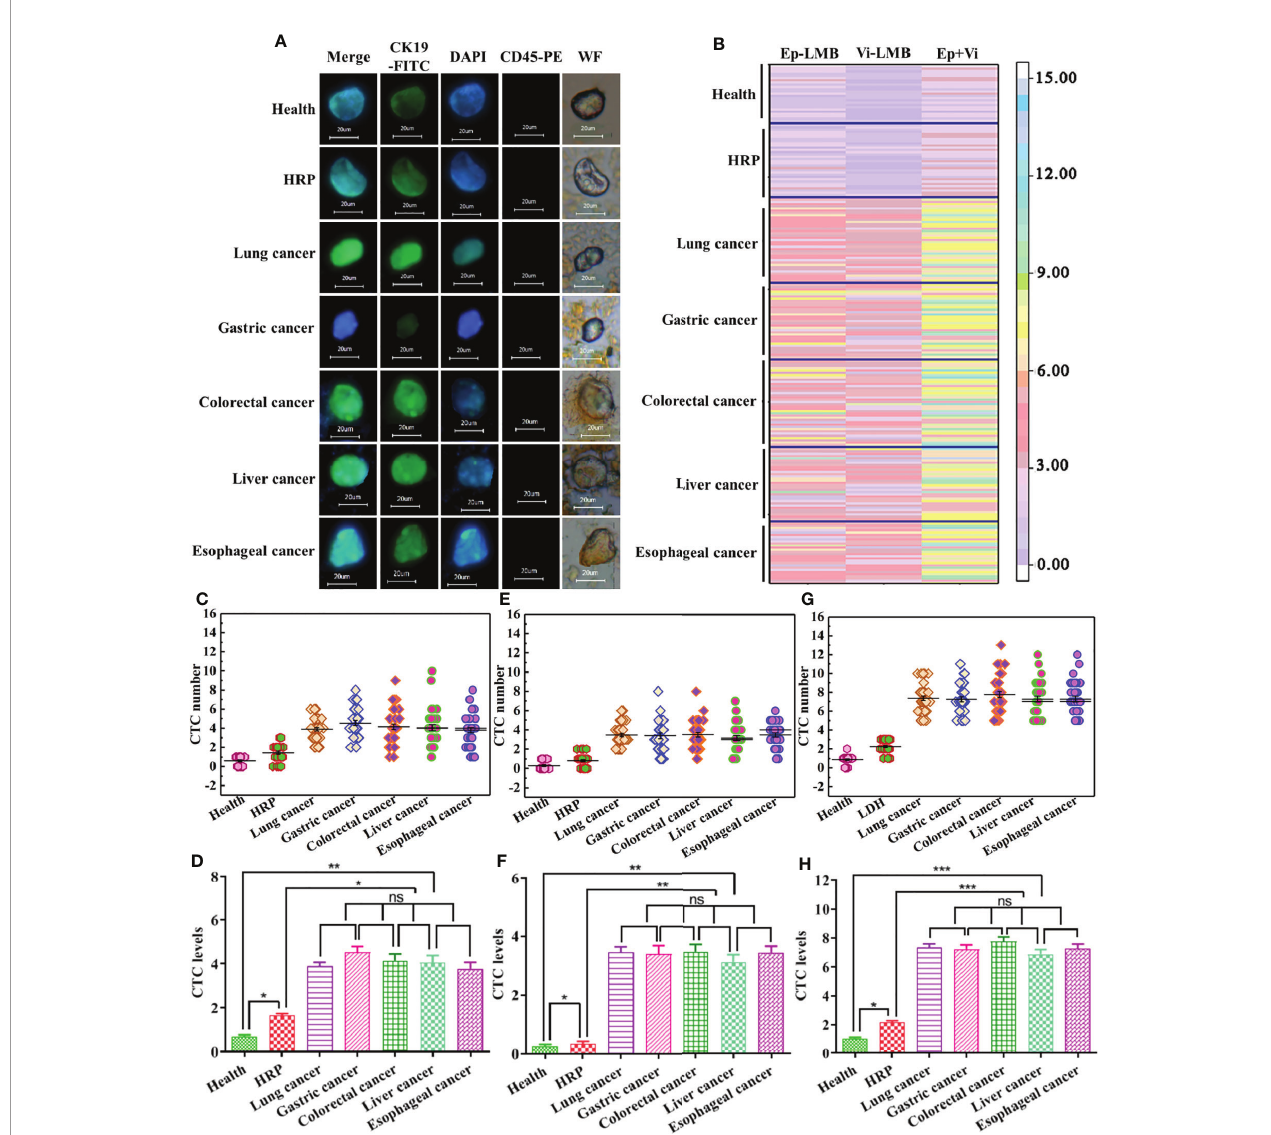
FIGURE 5 | Capture and identi fi cation of CTCs in clinical blood samples: (A) Immuno fl uorescence analysis of CTCs in blood samples of healthy subjects, HRP patients and patients with different types of cancer (scale: 20 m m); (B) Hotspot map of CTCs count captured by Ep-LMB and Vi-LMB in blood samples of healthy subjects, HRP patients and patients with different types of cancer; (C) Distribution of Ep-LMB CTCs in blood samples of healthy subjects, HRP patients and patients with different types of cancer; (D) Comparison of average count of Ep-LMB CTCs in blood samples of healthy subjects, HRP patients and patients with different types of cancer; (E) Distribution of Vi-LMB CTCs in blood samples of healthy subjects, HRP patients and patients with different types of cancer; (F) Comparison of average count of Vi-LMB CTCs in blood samples of healthy subjects, HRP patients and patients with different types of cancer; (G) Distribution of total CTCs in blood samples of healthy subjects, HRP patients and patients with different types of cancer; (H) Comparison of average count of CTCs in blood samples of healthy subjects, HRP patients and patients with different types of cancer. P>0.05 (ns), meant that the difference there was no statistically signi fi cant, P < 0.05 (*P < 0.05; **P < 0.01; ***P < 0.001) meant that the difference was statistically signi fi